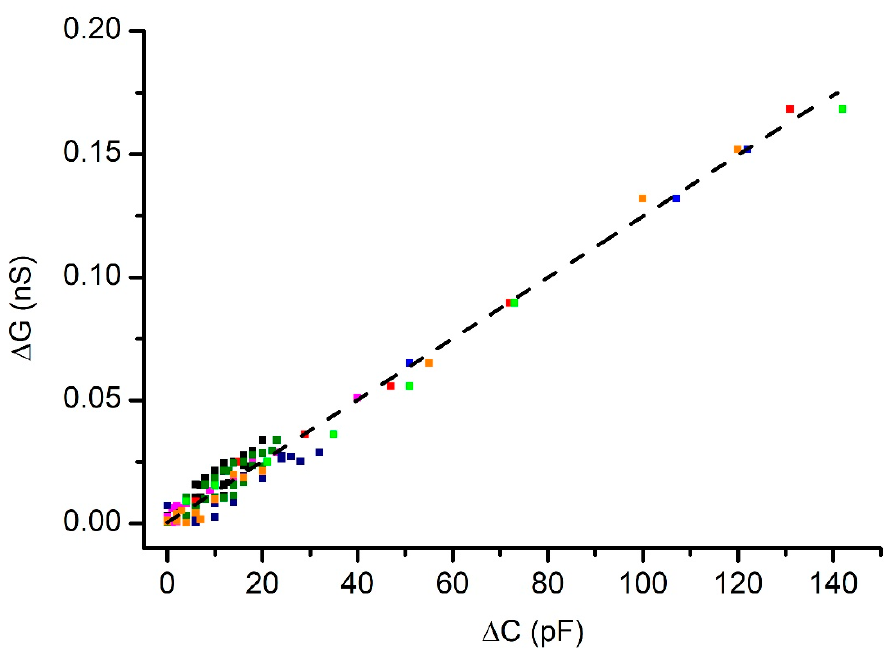
Figure 5. The changes in conductance correlate linearly with the changes in capacitance for a cholesterol-free membrane under differential hydrostatic pressure. The interrupted line represents the linear fit of the experimental data; the different colors used for symbols indicate independent experiments.